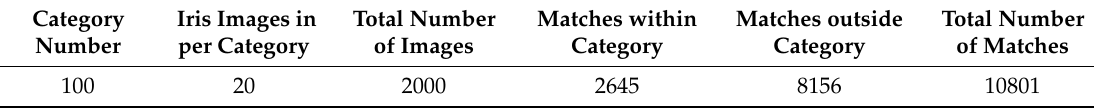
Table 5. Number of comparisons in decision layer experiment.